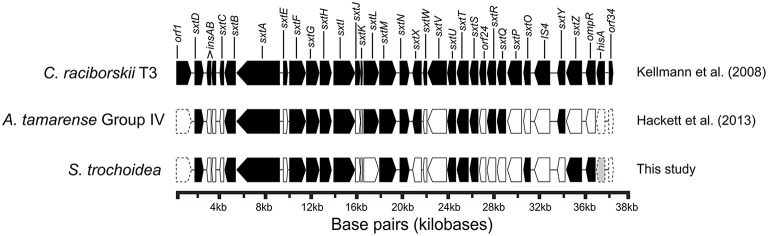
Gene arrangement of Saxitoxin gene cluster in Cylindrospermopsis raciborskii with homologs of Alexandrium tamarense and Scrippsiella trochoidea shaded to demonstrate shared gene similarity in both toxic and non-toxic dinoflagellates and the known cyanobacterial saxitoxin pathway (Adapted from Kellmann et al., 2008), and sxt gene hits of Alexandrium tamarense plotted from Hackett et al. (2013) in addition sxt gene hits from this study.